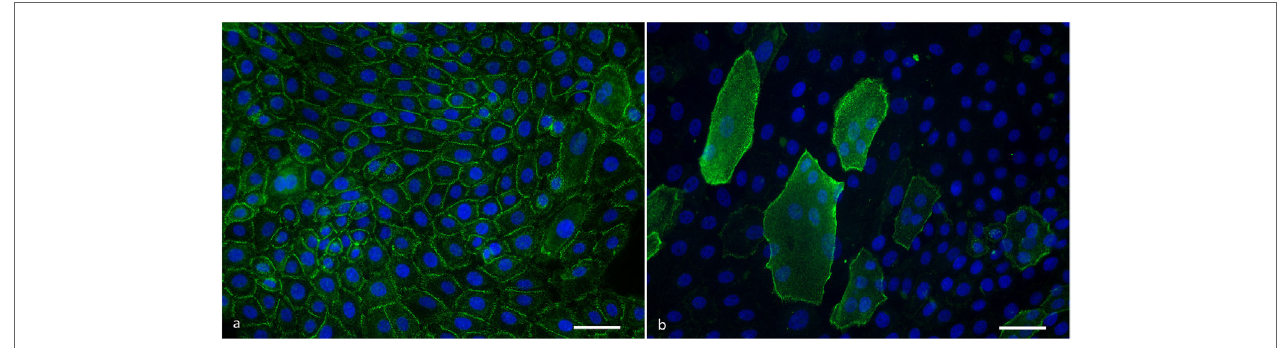
FigUre 2 | (a) Anti-Dsg3 IgG binding pattern to cultured keratinocytes showing desmosomal distribution at cell–cell contacts. Scale bar is 50 µm. (B) Anti-desmoglein 1 IgG binding pattern to cultured keratinocytes showing a desmosomal distribution at the cell periphery of differentiated cells. Scale bar is 50